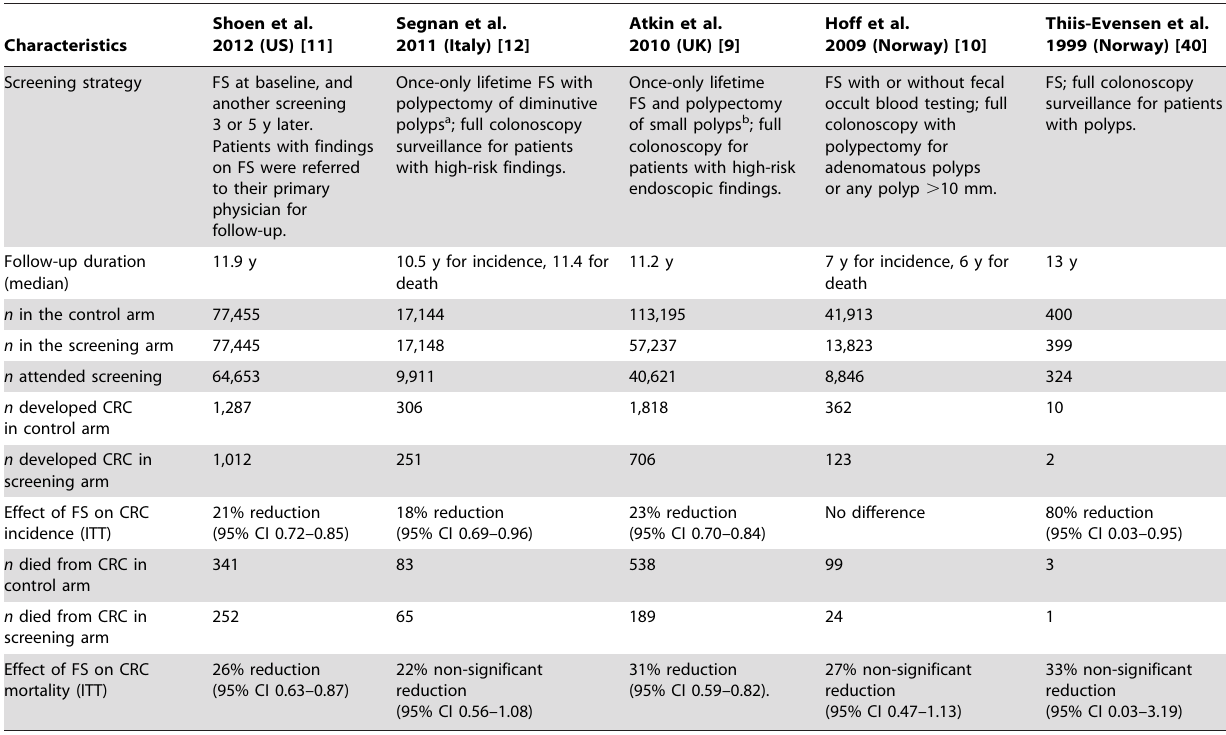
Table 1. Characteristics of included studies.